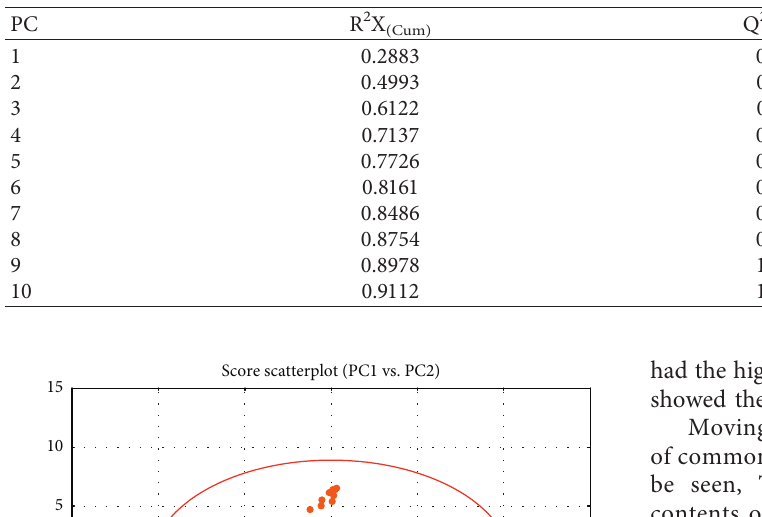
Figure 2: Eigenvalues scree plot of the principal components. Table 2: Principal component analysis summary.